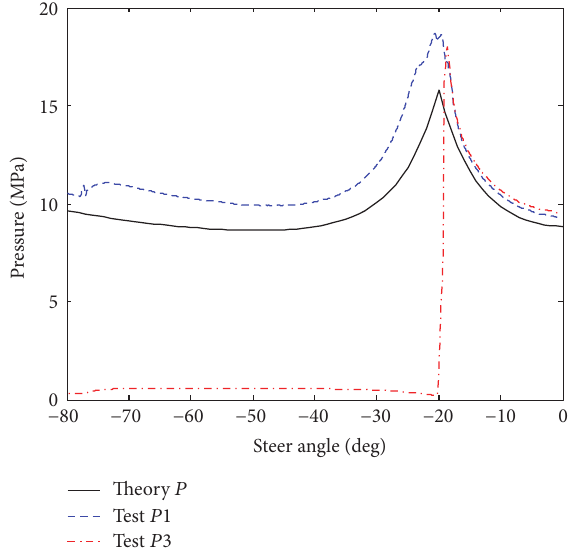
Figure 30: Comparison of pressure between test and theory results.